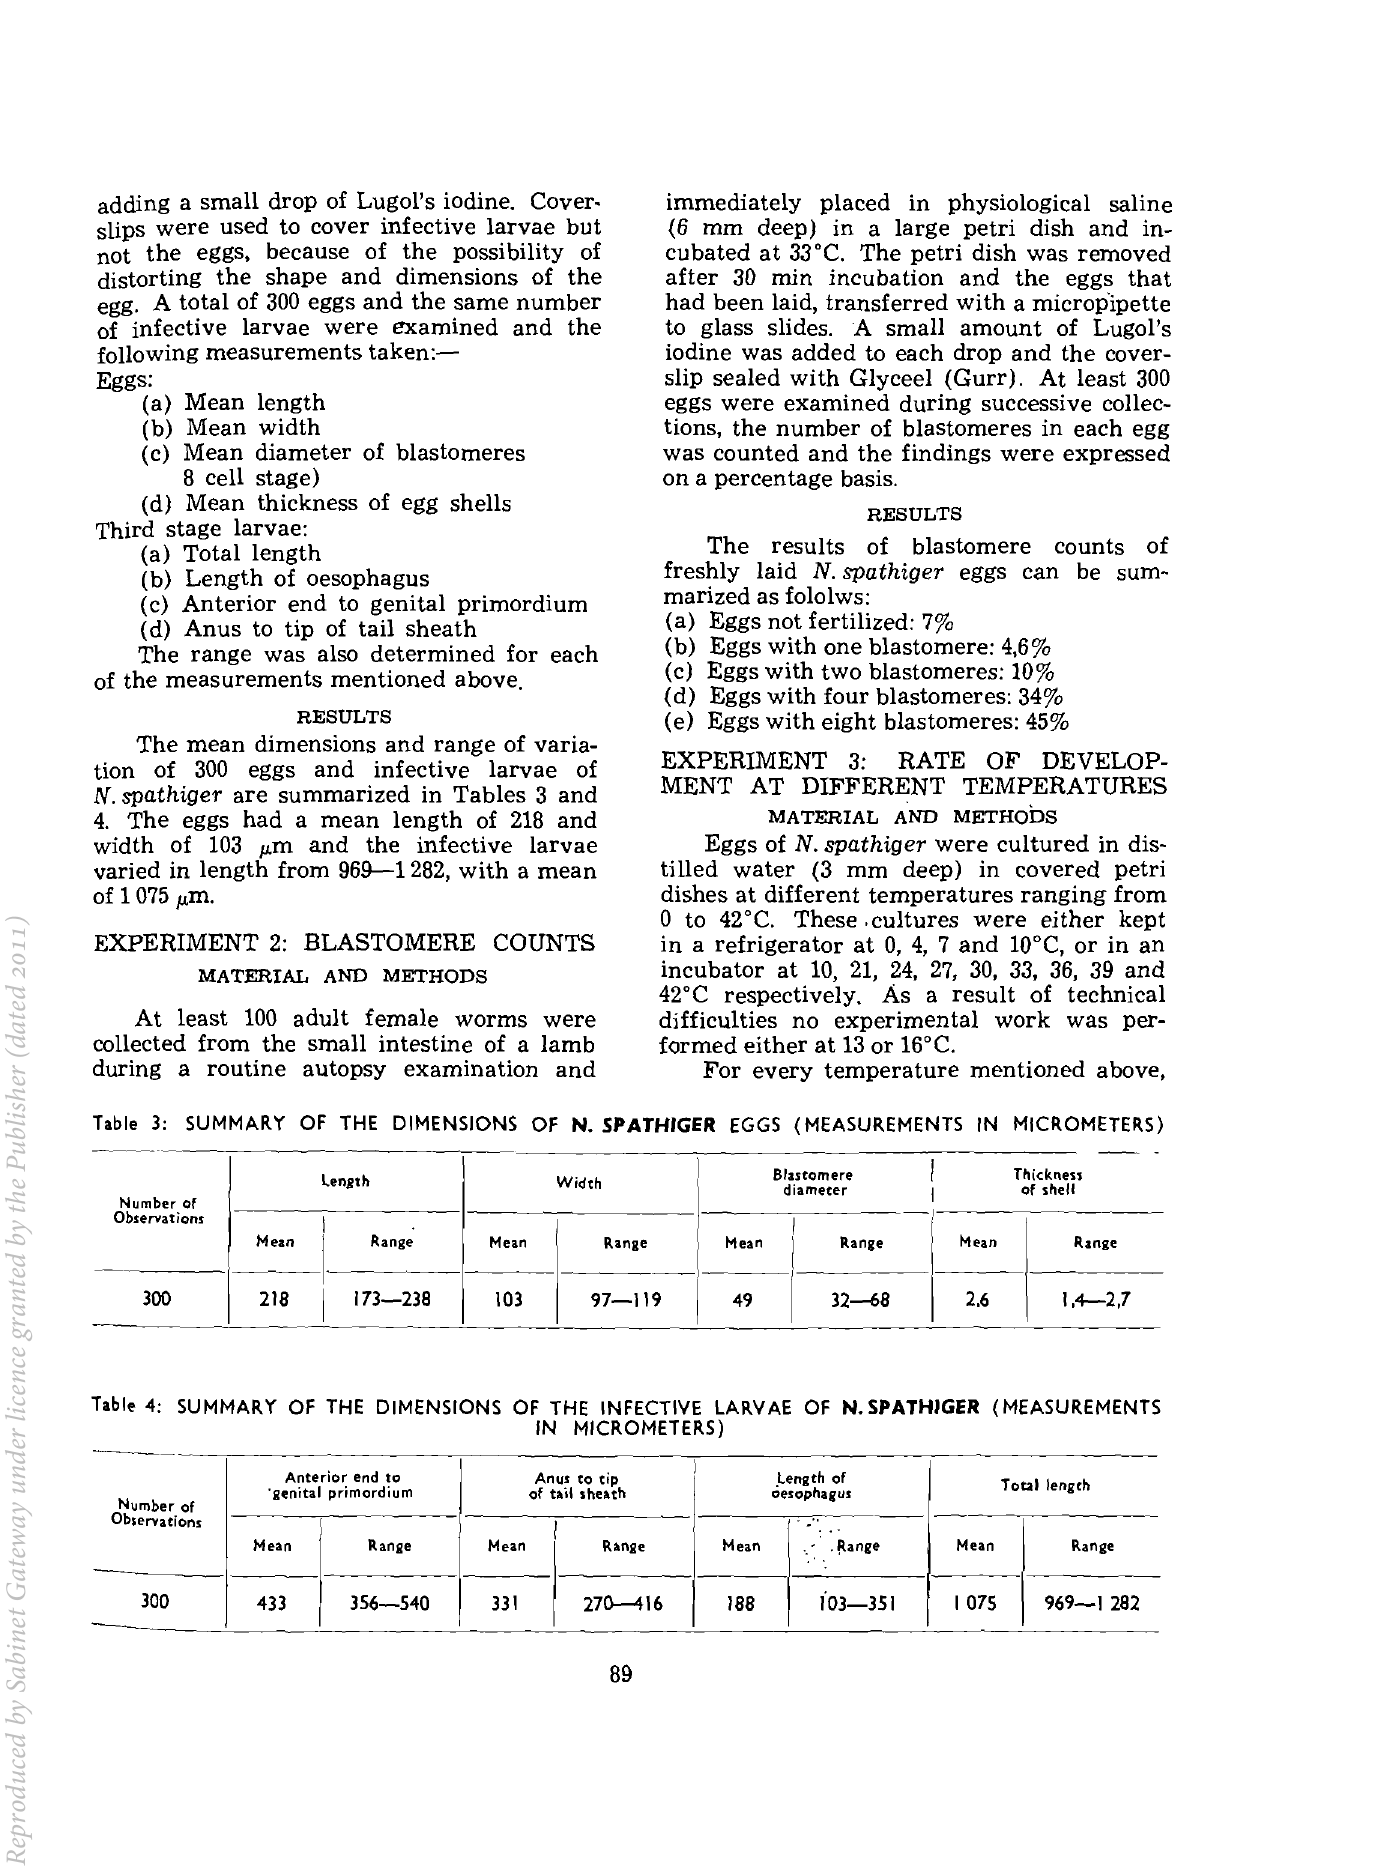
IN MICROMETERS) - - ) .length of I Total length